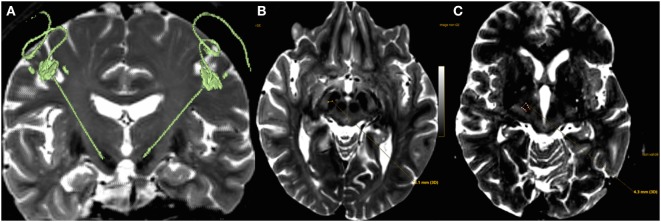
(A) 3D T2 sequence fused with postoperative CT showing electrodes placement within both subthalamic nucleus. (B) The first boundary of the “distance measurement tool” was adjusted on the center of the deep brain stimulation (DBS) contact visualized on the coronal plane of the CT image, here visible on an axial plane (T2-MRI; medial yellow point), extracted from the MRI-CT fusion; the lateral yellow point is the medial border of the corticospinal/corticobulbar tracts (CSBT) and was adjusted on the axial plane (MRI window). (C) For dorsal contacts (all four DBS contacts are represented medially, the most ventral one in red, the most dorsal one being the most anterior), the closest border of the CSBT to the electrode is no more medial but anterior or antero-medial.